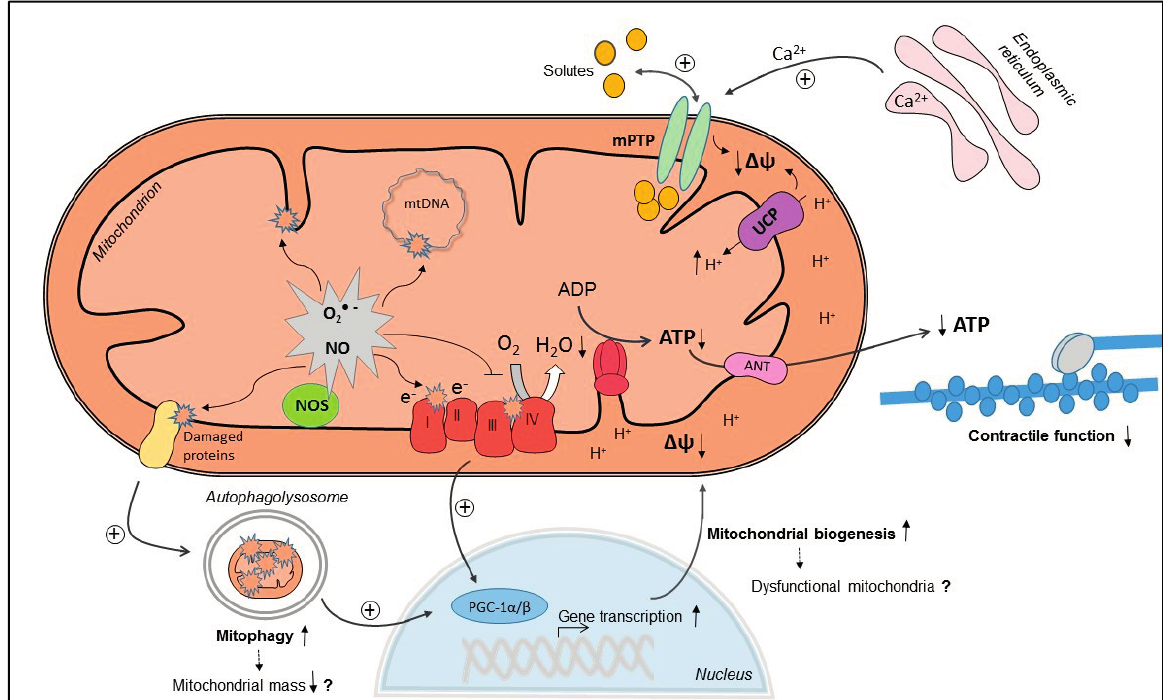
Figure 1. Mitochondrial mechanisms in septic cardiomyopathy: Increased superoxide (O 2 · − ) and nitric oxide (NO) production can cause direct oxidative or nitrosative damage and inhibition of oxidative phosphorylation (OXPHOS) complexes, leading to decreased O 2 consumption and decreased mitochondrial membrane potential ( Δψ ). In addition, Δψ may drop due to increased uncoupling protein (UCP)-mediated proton leak, increased Ca 2+ -induced mitochondrial permeability transition pore (mPTP) opening and direct oxidative damage of the inner mitochondrial membrane. As a consequence, mitochondrial ATP regeneration is compromised, and energy depletion may contribute to cardiac contractile dysfunction. Increased mitophagy may eliminate dysfunctional mitochondria, which may be replaced by increased mitochondrial biogenesis, mediated by activation of peroxisome proliferator-activated receptor γ coactivator 1 α / β (PGC-1 α / β ). However, if uncoordinatedly activated, mitophagy and mitochondrial biogenesis may lead to decreased mitochondrial mass and dysfunctional mitochondria (upward pointing arrow: increase; downward pointing arrow: decrease; dashed arrow: possible